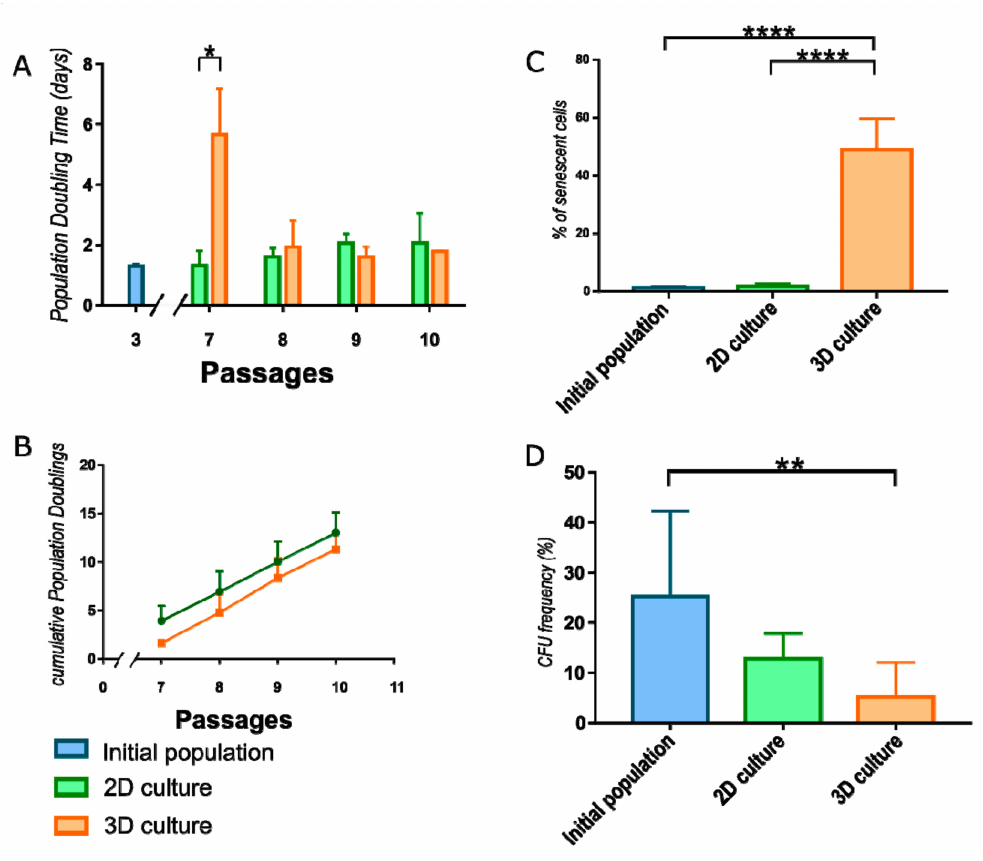
Figure 3. Characteristic of WJ-MSC cultured in different conditions. ( A ) Population doubling time (PDT) for WJ-MSC cultured in 2D and 3D. 3D cultured WJ-MSC divided more slowly than 2D cultured WJ-MSC during the first passage. However, there are observed no differences in next 3 passages. ( B ) Cumulative Population Doublings calculation revealed shift between 2D and 3D cultured populations. ( C ) Senescence process analysis. Number of cells expressing β -galactosidase was significantly higher in 3D cultured WJ-MSC than in initial and 2D cultured populations. ( D ) Colony forming unit (CFU) frequency reduced significantly during 3D culture of WJ-MSC. Following populations of WJ-MSC were used: from 3rd passage (initial populations), from 7th passage (2D culture) and cultured as spheroids (3D culture). The results are presented as mean values of 3 experiments ± SD. For * < 0.05, ** <0.01, **** <